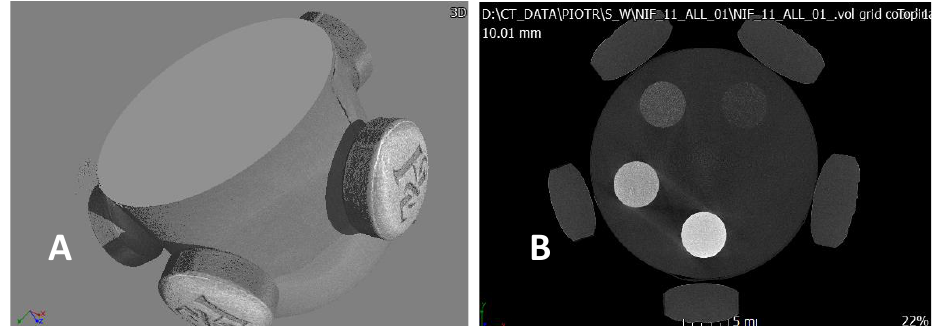
Figure 2. Arrangement of the tablets around the microtomographic cylinder ( A ). The calibration phantom with the standards ( B ).